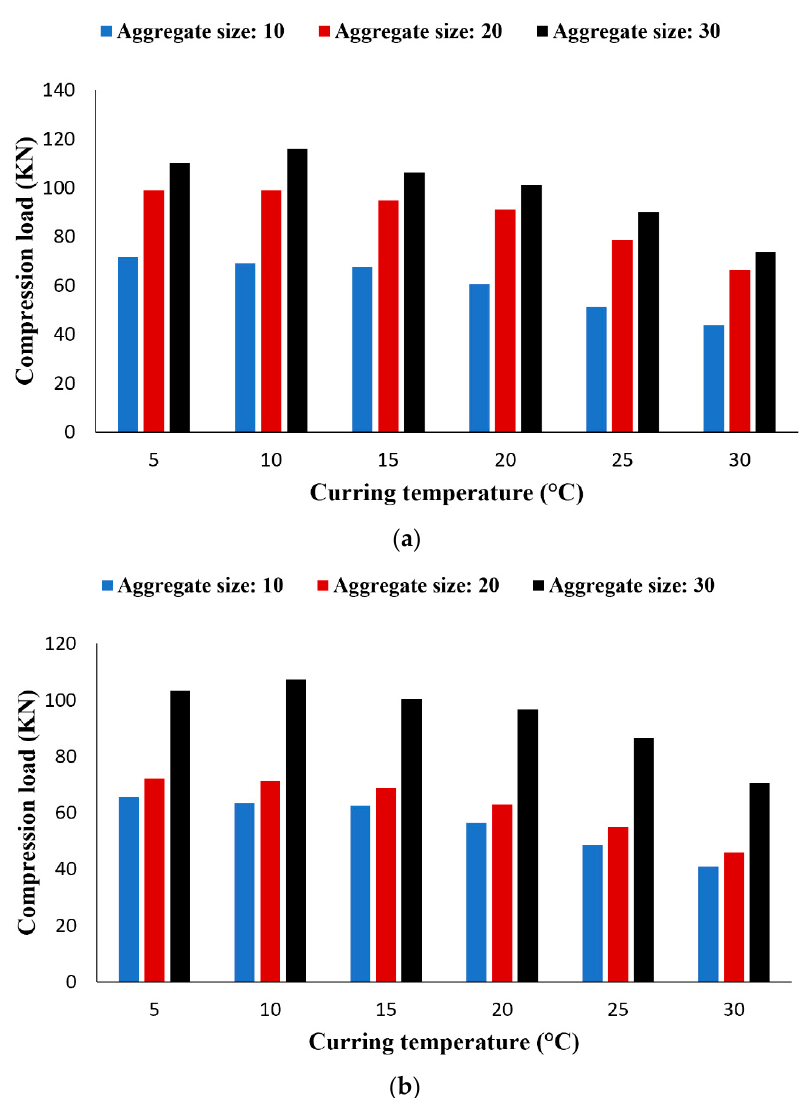
Figure 5. Bar chart of concrete compressive strength in terms of different curing conditions consid- ering various geometries of aggregate, including ( a ) rounded aggregates and ( b ) angular